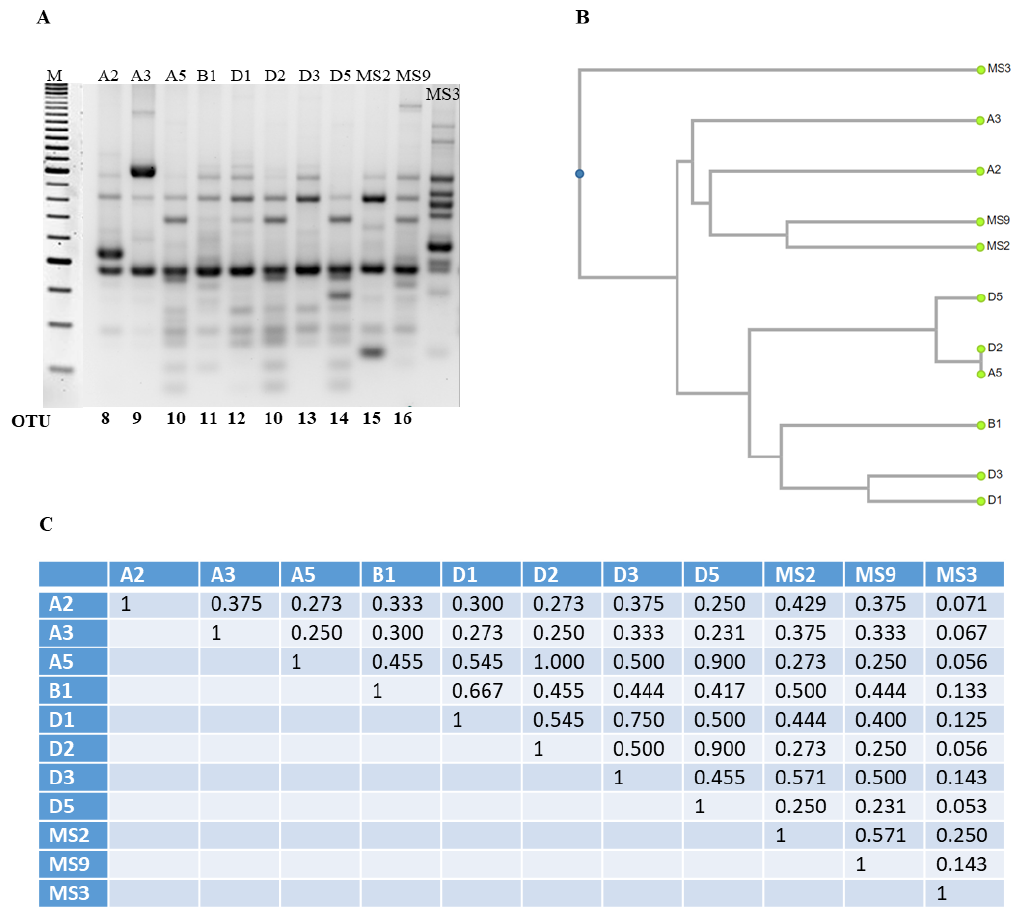
Figure 4. ( A ). RAPD patterns obtained with primer RAPD1. RAPD-PCR products were obtained from the DNA of dif- ferent clones of L. lactis subsp. lactis isolated from NWSb (A2, A3, A5, B1, D1, D2, D3, D5, MS2, MS9, and MS3). L. lactis subsp. cremoris (lab collection) was used as control. The patterns are grouped in clusters (OTU, Operational Taxonomic Units) according to the unweighted pair group method algorithm with arithmetic mean (UPGMA) analysis. ( B ). Den- drogram obtained from RAPD- PCR patterns, based on the Jaccard’s similarity coefficient, shown in panel C. ( C ). Genetic similarity matrix of the analyzed clones, based on RAPD data and computed using Jaccard’s coefficient (UPGMA analy-